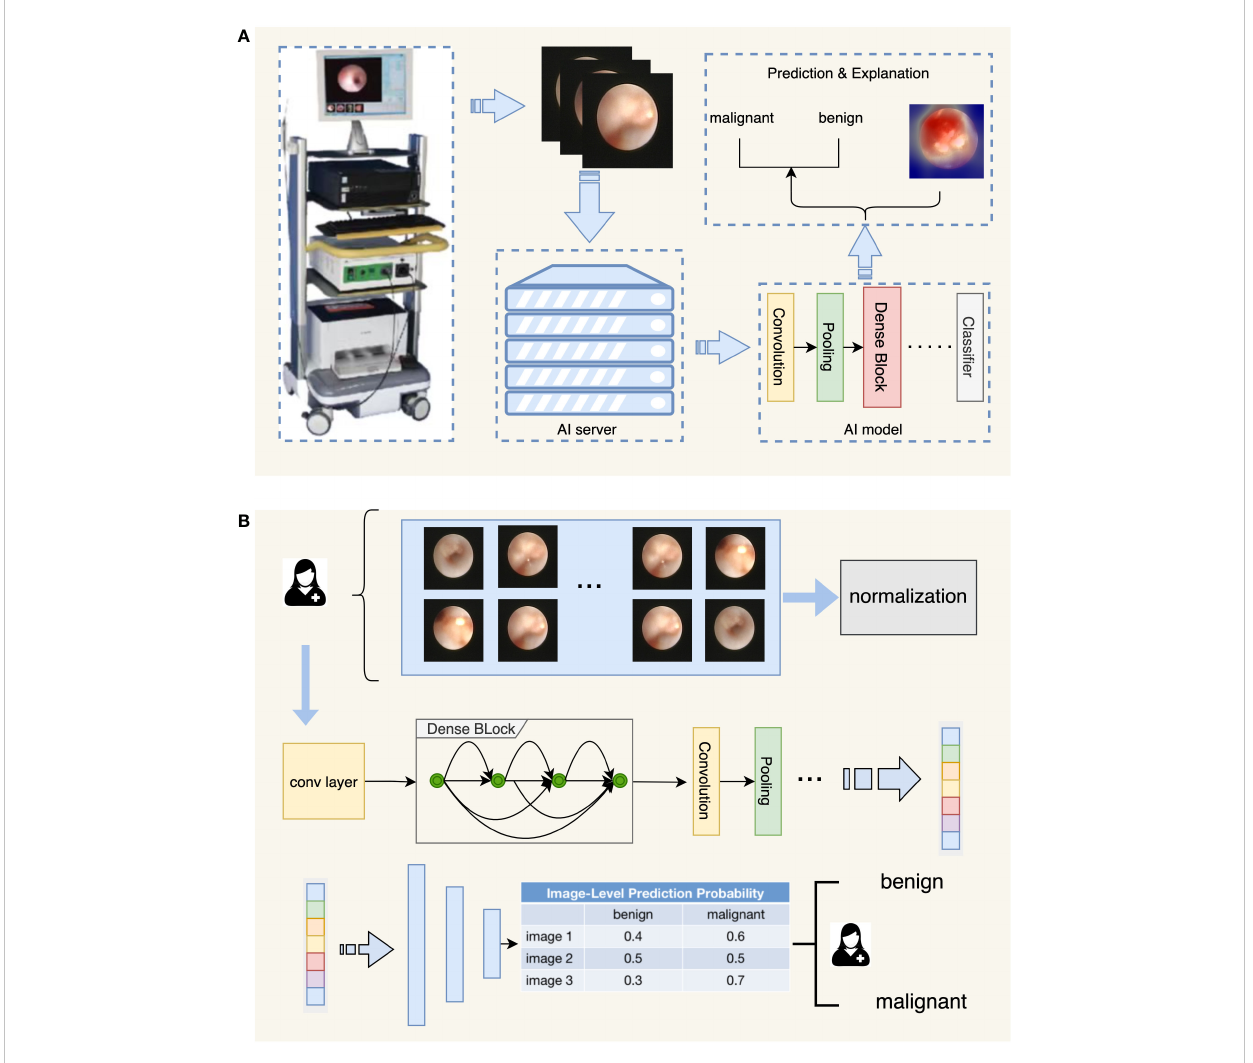
FIGURE 1 Flowchart depicting the diagnostic process of IDBCS. Part (A) in this fi gure shows the whole process of automatic diagnosis of ductoscopy images. The image obtained by the ductoscopy machine is transmitted to the server containing the AI algorithm in real-time, and the result is given after the automatic diagnosis of the AI algorithm, and the corresponding explanation is given for the diagnosis result. Part (B) in this fi gure shows the model structure of the diagnosing algorithm. Ductoscopy images were normalized fi rst and then fed into the DenseNet model. DenseNet contains several Dense Blocks and calculates features of the input images. The output features were fed into the classi fi er with a voting mechanism and the diagnosing result was